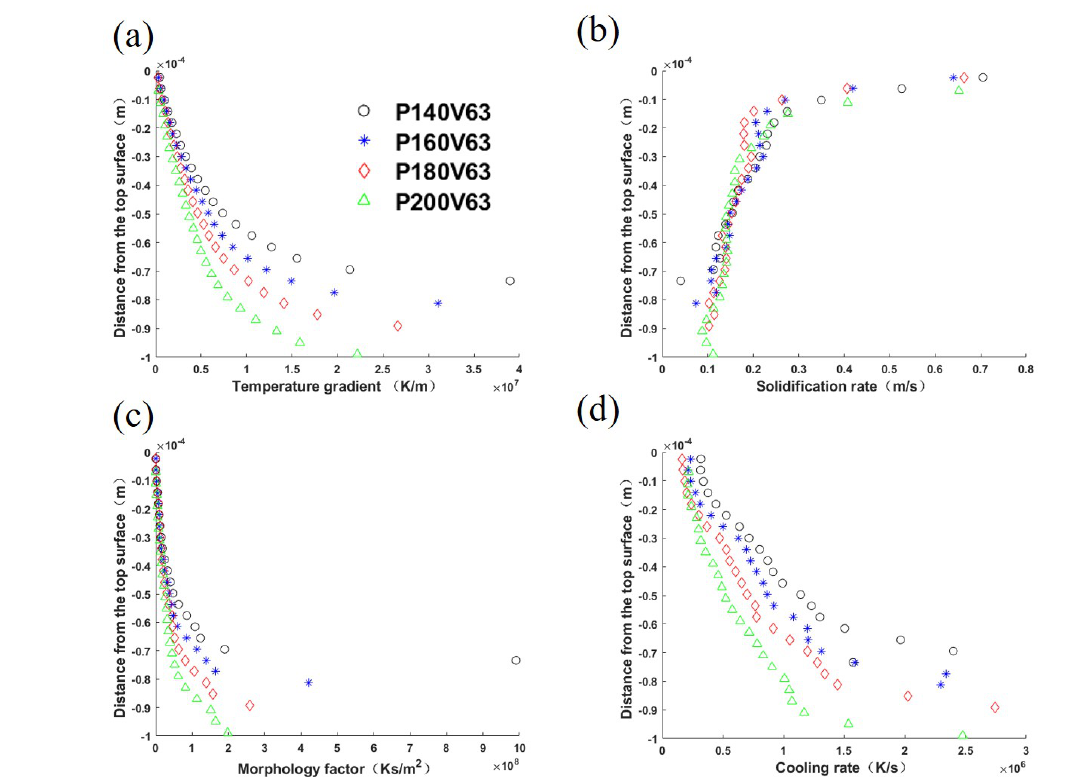
Figure 10. Solidification parameters of the longitudinal section of the melt pool center: ( a ) temperature gradient magnitude G , ( b ) solidification rate R , ( c ) morphology factor M = G / R , and ( d ) cooling rate C = G · R , for cases with laser power varied within the range [140 W, 200 W], and constant laser scan speed of 0.63 m/s. The abscissa represents the distance from the top surface of the melt